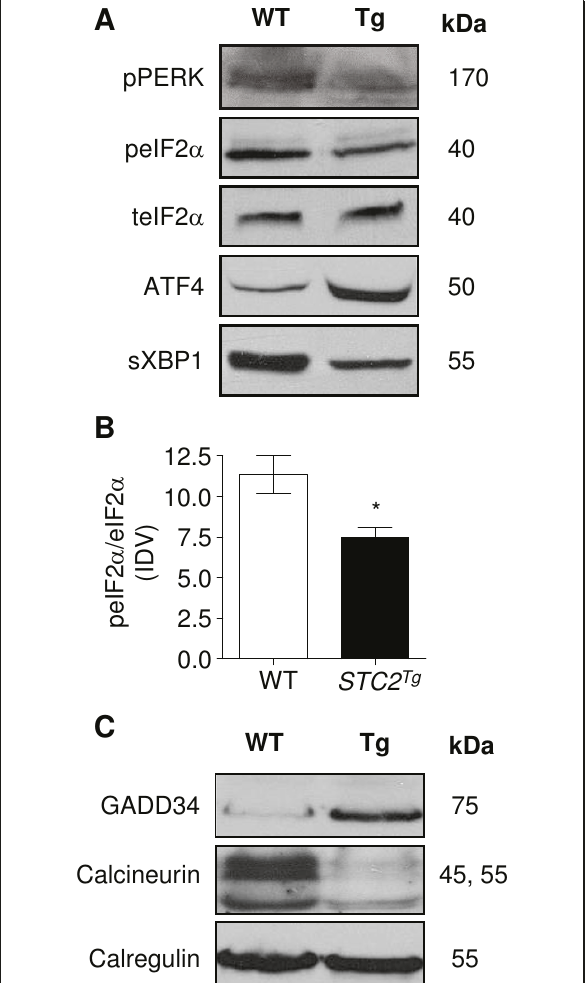
Figure 3 Systemic over-expression of STC2 ( STC2 Tg ) alters the PERK signalling pathway in pancreatic tissue . (A) Representative Western blot analysis for mediators of PERK signalling: pPERK, peIF2 a , total (t) eIF2 a , ATF4 and sXBP1 in wild type (WT) and STC2 Tg (Tg), revealed decreased levels of pPERK, peIF2 a and sXBP1, and increased amounts of ATF4 in STC2 Tg mice. (B) Densitometry revealed that the ratio of peIF2 a to total eIF2 a is decreased in STC2 Tg extracts relative to WT tissue (n = 3 animals; *p < 0.05). (C) Similar western blot analysis revealed increased accumulation of GADD34 and decreased accumulation of calcineurin in STC2 Tg pancreatic protein extracts. No difference in calregulin accumulation was observed. Molecular weights (kDa) are provided.